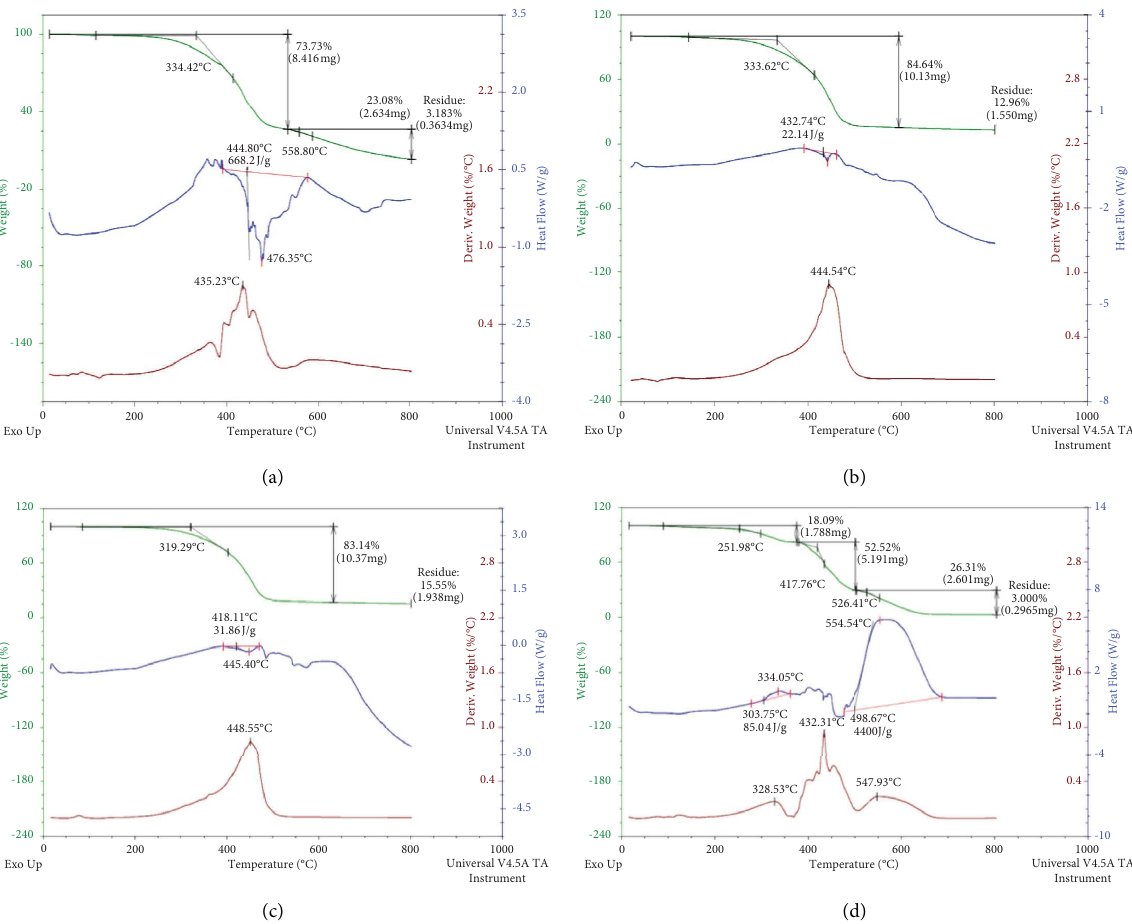
Figure 12: TG-DSC curve. (a) Base emulsifed asphalt. (b) 1.5% SBS modifed emulsifed asphalt. (c) 3% SBR modifed emulsifed asphalt. (d) SBS/SBR modifed emulsifed asphalt.